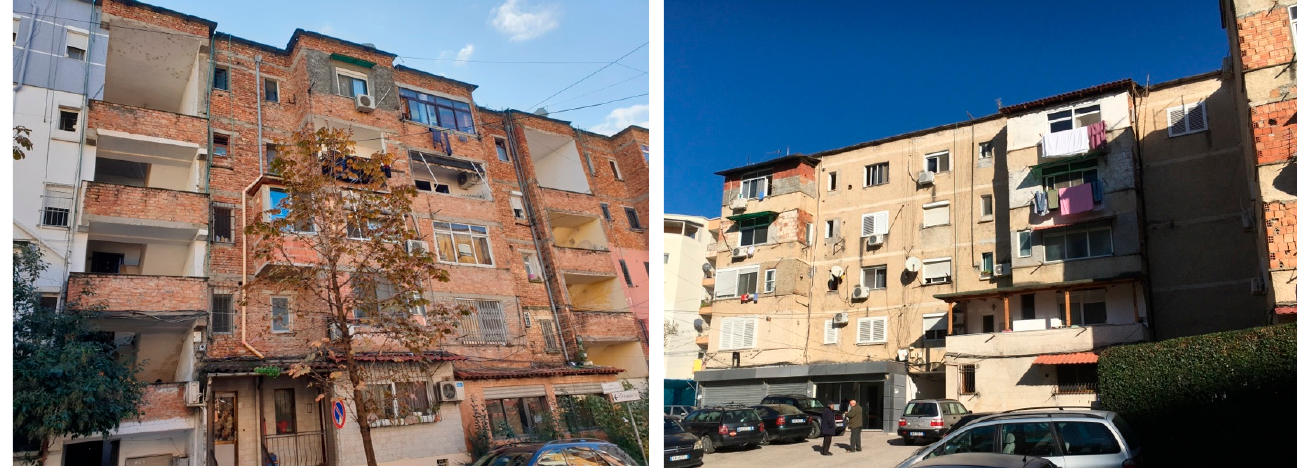
Figure 12. Representative pictures of the building screening data collected after the 2019 Albania earthquake.